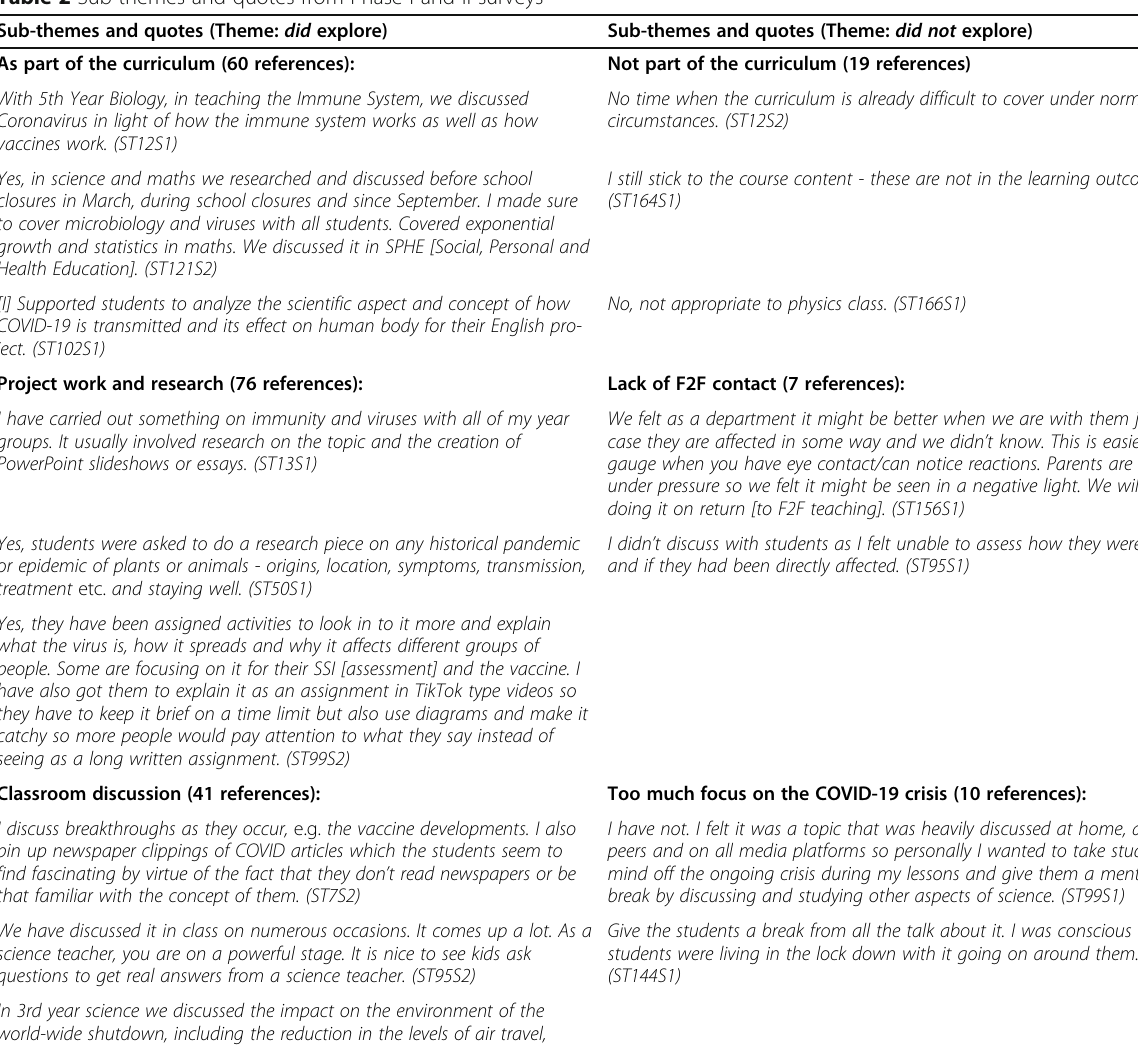
Table 2 Sub-themes and quotes from Phase I and II